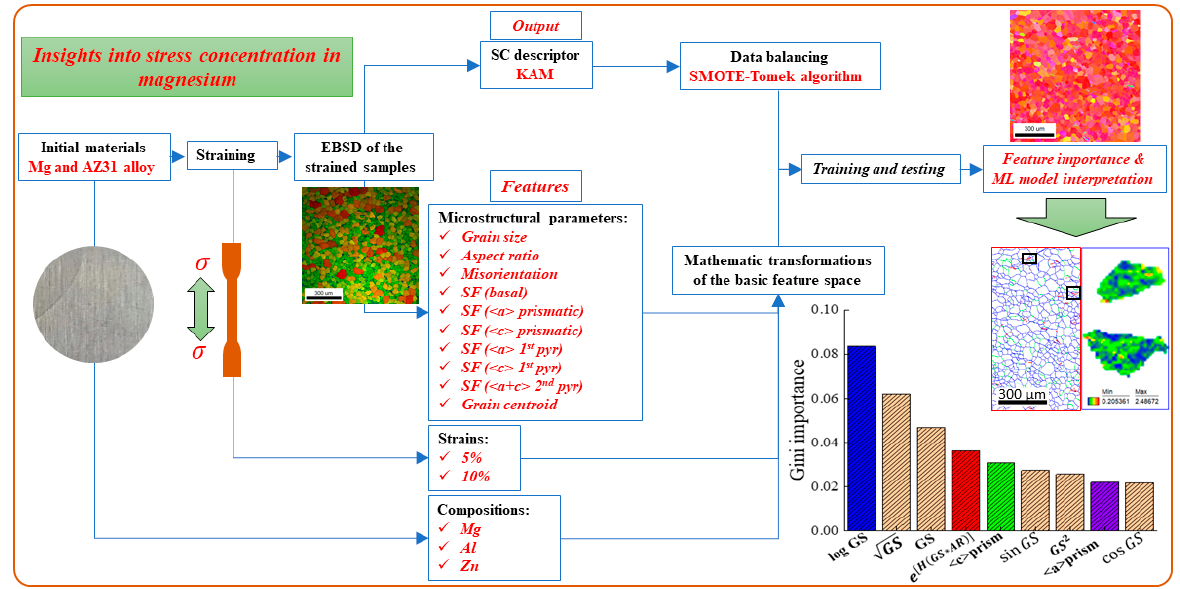
Figure 7. The machine learning loop used in the present work to figure out the microstructural parameters that are highly expected to influence the stress concentration in Mg based materials.